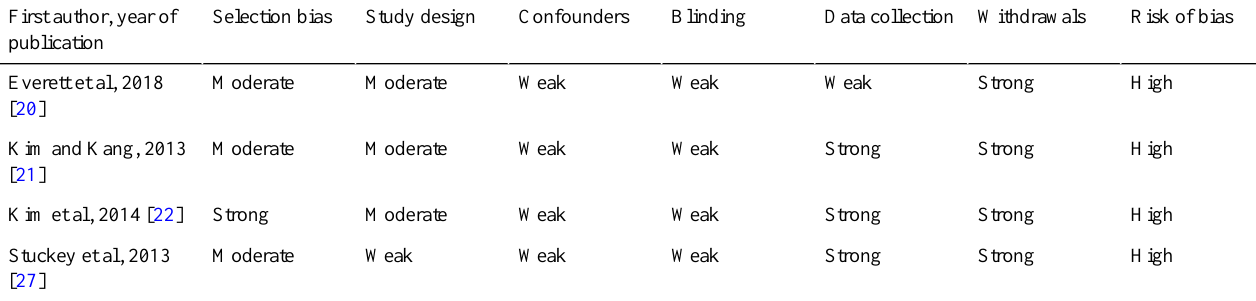
Table 2. Quality assessment of the included pre-post studies.